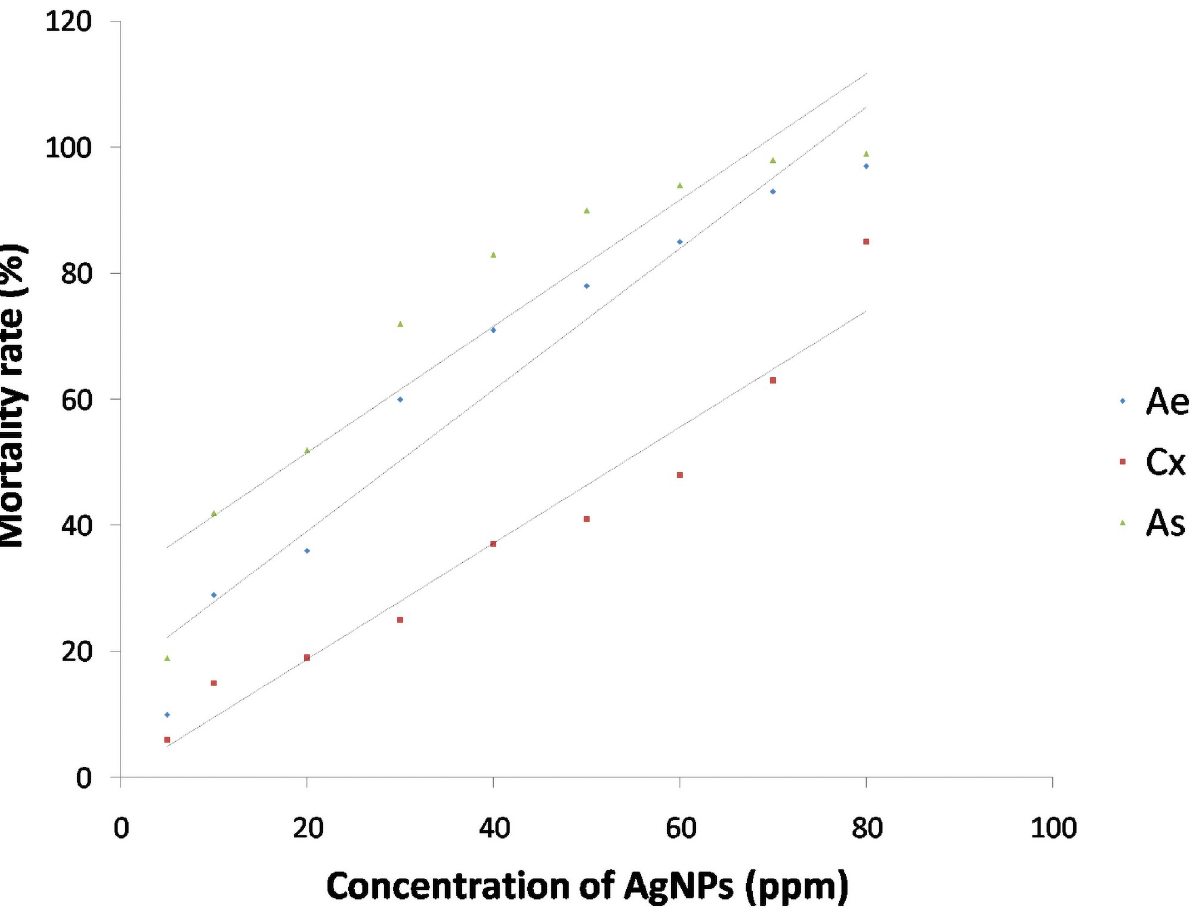
Fig 13. Mortality curves for larvicidal activity of AgNPs synthesized by Bacillus marisflavi against 4 th instar larvae of Ae . aegypti , Cx . quinquefasciatus and An . Stephensi .